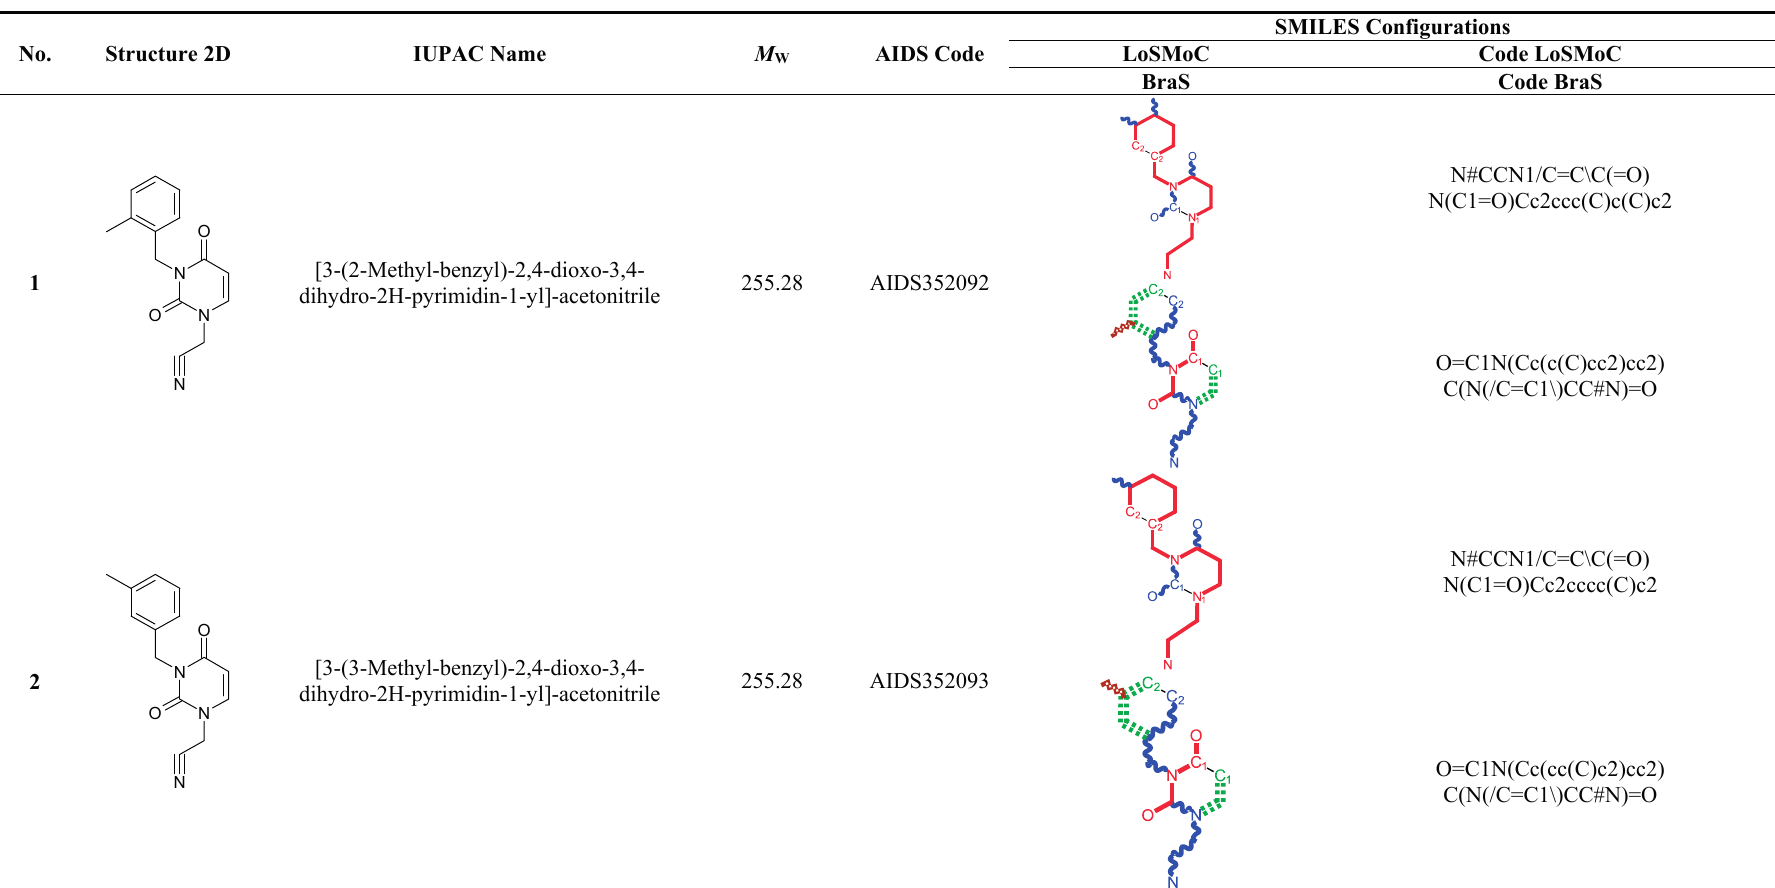
Table 1. Working molecules (IUPAC name and molecular weight MW are indicated ) and their corresponding SMILES topology, i.e. , the longest SMILES molecular chain (LoSMoC) as upper entry and the Branching SMILES (BraS) as down entry, for each pyrimidine structure considered, manifesting antiviral activity of 1,3-disubstituted uracils against human immunodeficiency virus (HIV-1) [87], with AIDS code indicated [96], respectively. SMILES legend is: principal SMILES chain; secondary SMILES branch; tertiary SMILES branch; quaternary SMILES branch; = double bond; # triple bond; /,\ directional bonds; ( ) branch; C, N, F, S, I–atoms present in the